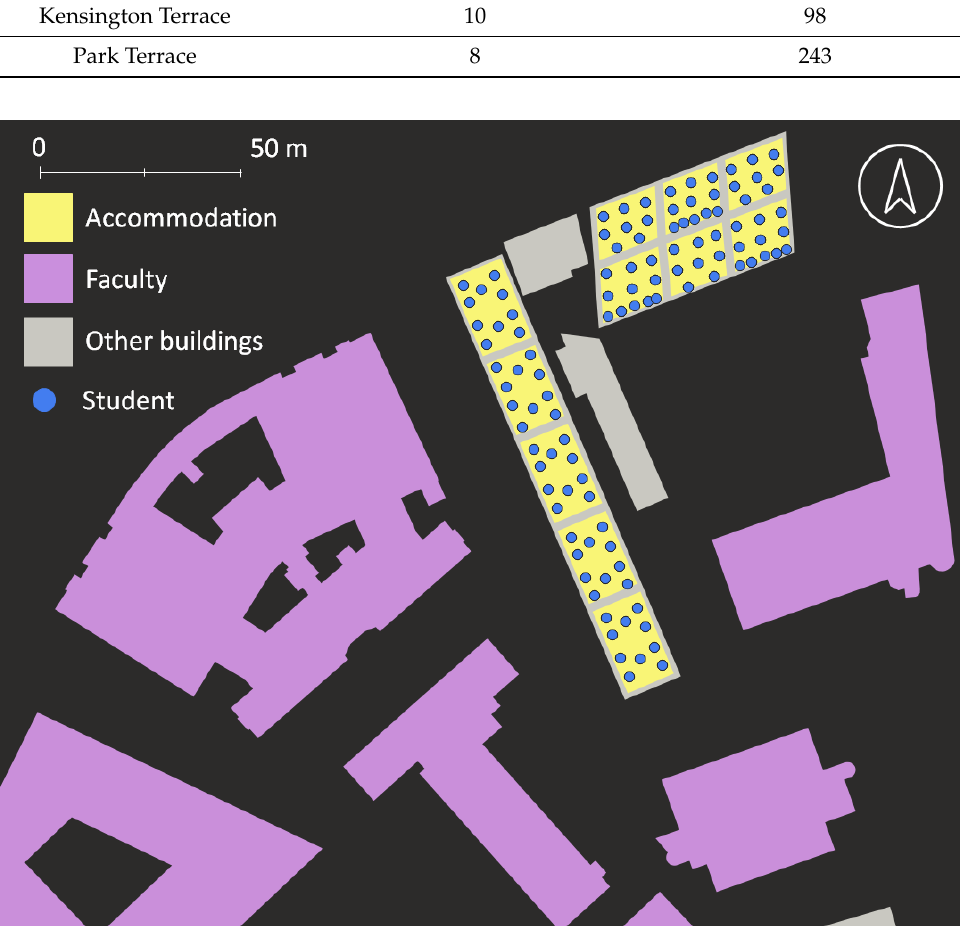
Figure 3. Detail of the location of students inside accommodations keeping a minimum 2 m distance between them. Contains Ordnance Survey data © Crown copyright and database right 2020.